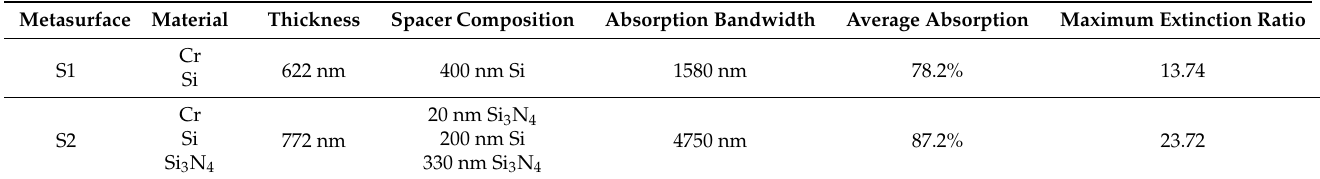
Figure 5. Diagram of high-performance metamaterial absorber with p = 800 nm, w = 560 nm, h = 200 nm, d = 550 nm, and t = 22 nm. Table 1. Comparison of structural parameters and numerical simulation results of designed metamaterials.